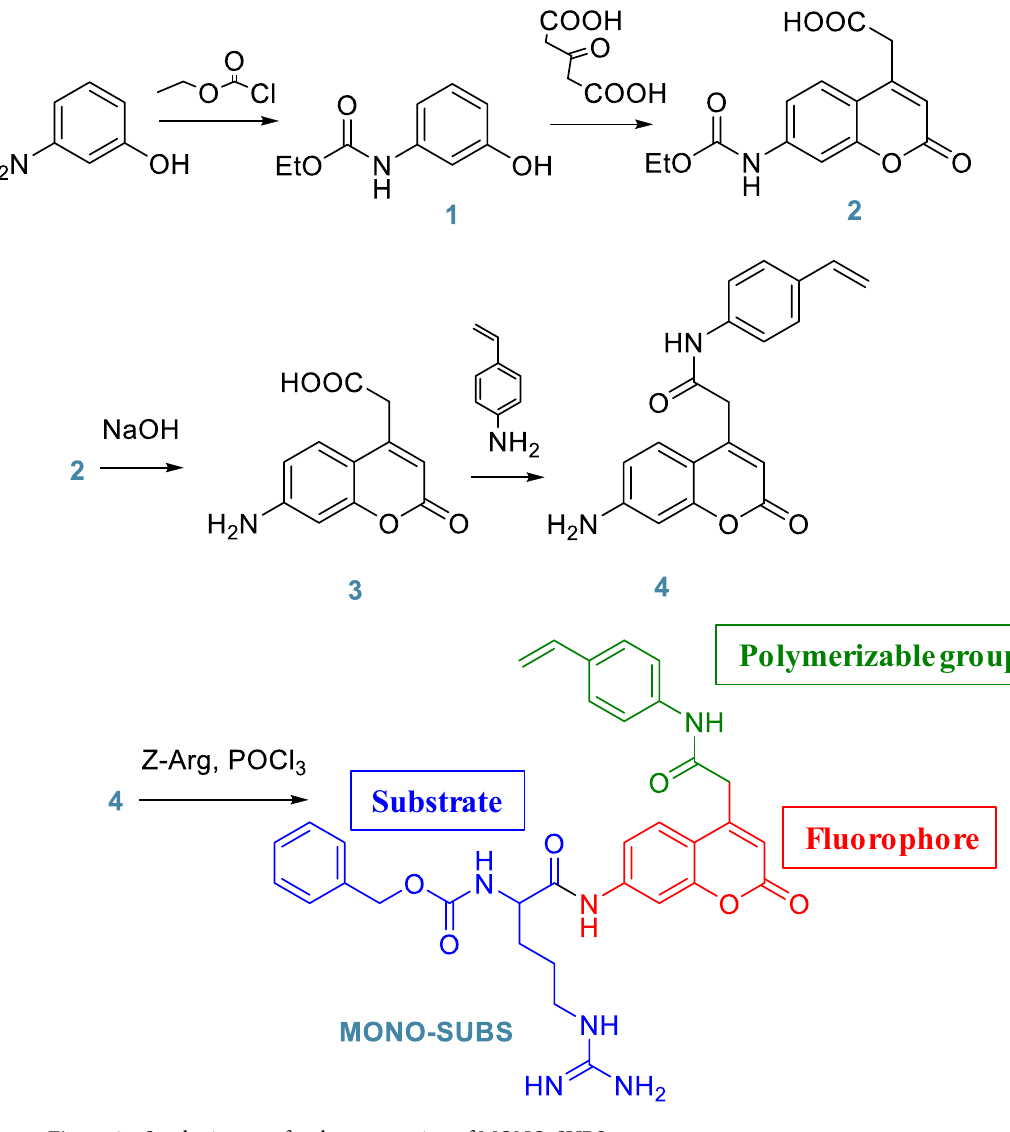
Figure 2. Synthetic route for the preparation of